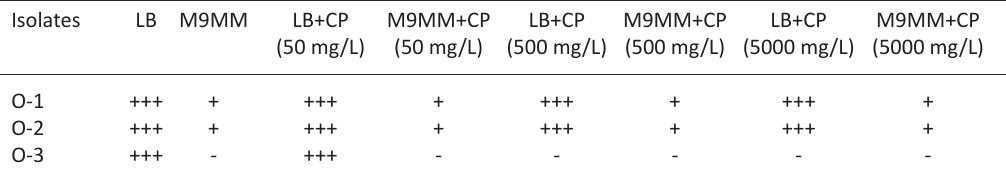
Table 3. Bacterial growth on LB agar and M9MM agar media having different concentration of CP following 72 hours of incubation